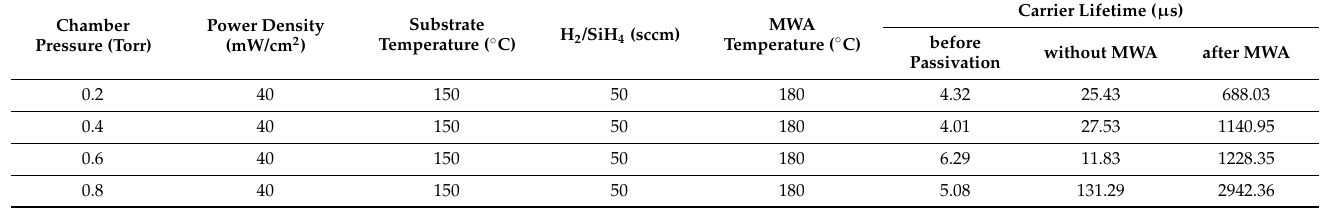
Table 1. Properties of the deposited nc-Si:H mixed-phase thin films. Note: MWA = microwave annealing.